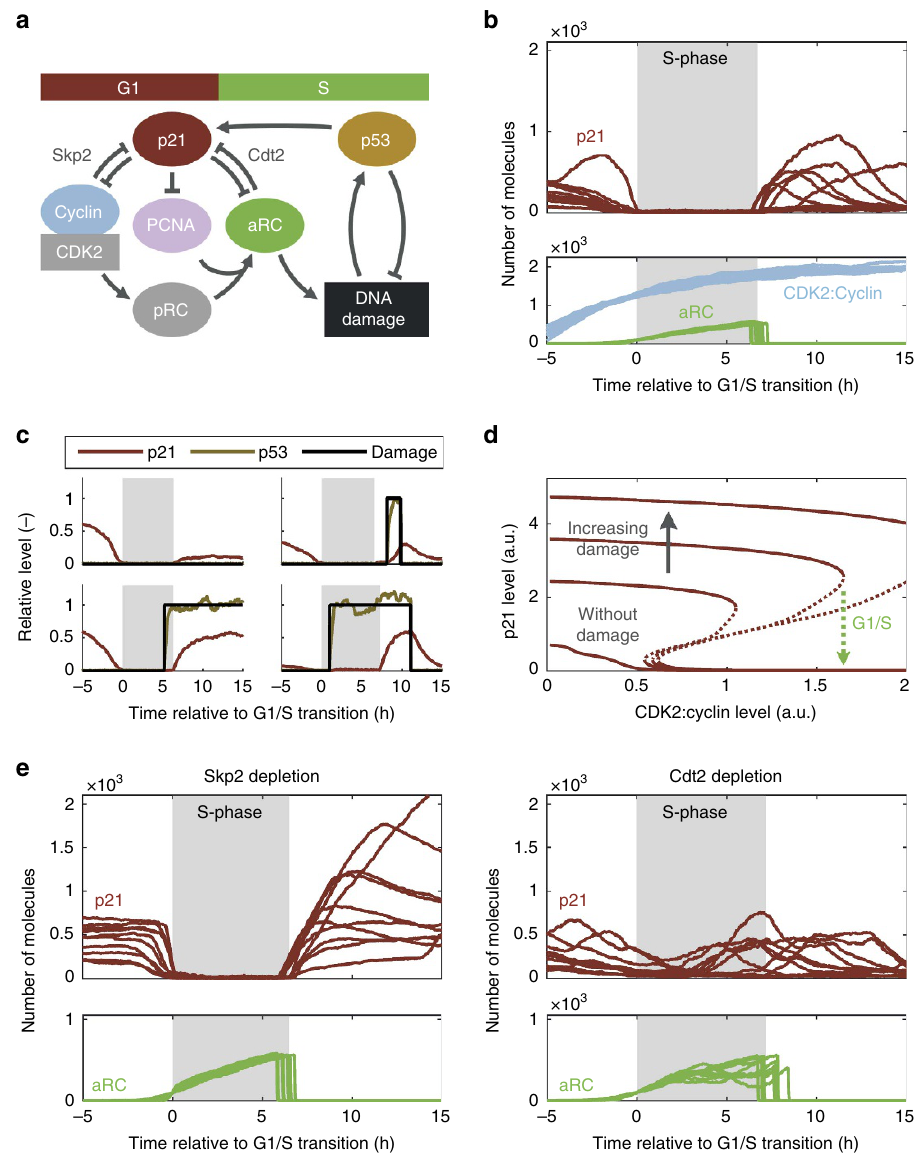
Figure 6 | Two double-negative feedback loops control p21 degradation. ( a ) Influence diagram of the p21 regulatory network. p21 is engaged in two mutually inhibitory motifs with CDK2:Cyclin and aRCs. CDK2 activity primes replication complexes (pRC) for PCNA loading, which facilitates S-phase entry and DNA synthesis by aRCs. The latter can cause DNA damage and p53 expression, promoting p21 synthesis and DNA repair. ( b ) Stochastic simulation of p21 (top), and total CDK2:Cyclin and aRCs (bottom), relative to the G1/S transition; n ¼ 10. Grey shaded regions indicate S-phase. ( c ) Relative level of p21, p53 and DNA damage in four simulated cells. Grey shaded regions indicate S-phase. Note p21 absence in S-phase even in cells that suffer damage (for example, lower right). ( d ) Stable (solid) and unstable (dashed) steady states of p21 with respect to the total level of CDK2:Cyclin for increasing DNA damage. The G1/S transition is indicated for intermediate levels of damage. ( e ) Stochastic simulation of p21 (upper panels) and aRCs (lower panels) in Skp2-depleted (left) and Cdt2-depleted (right) cells; n ¼